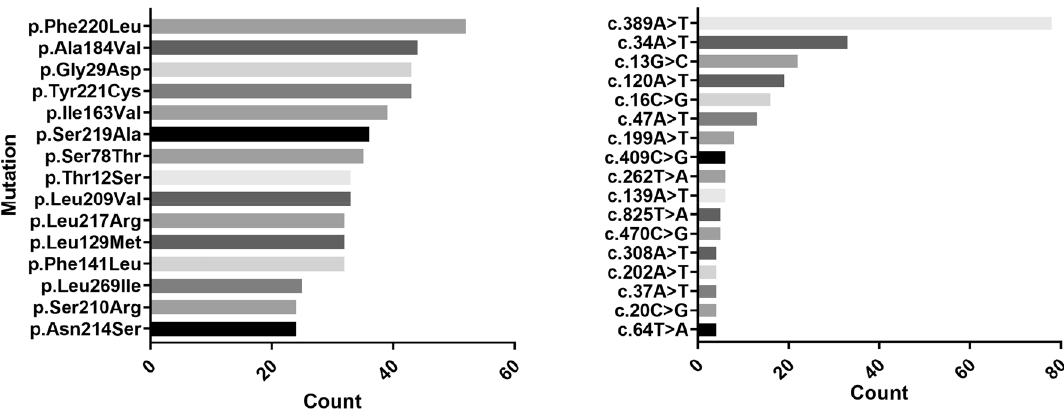
Figure 3. Top 10 most frequent amino acid mutations (left) and nucleotide mutations (right) in the clinical data that were also found in the